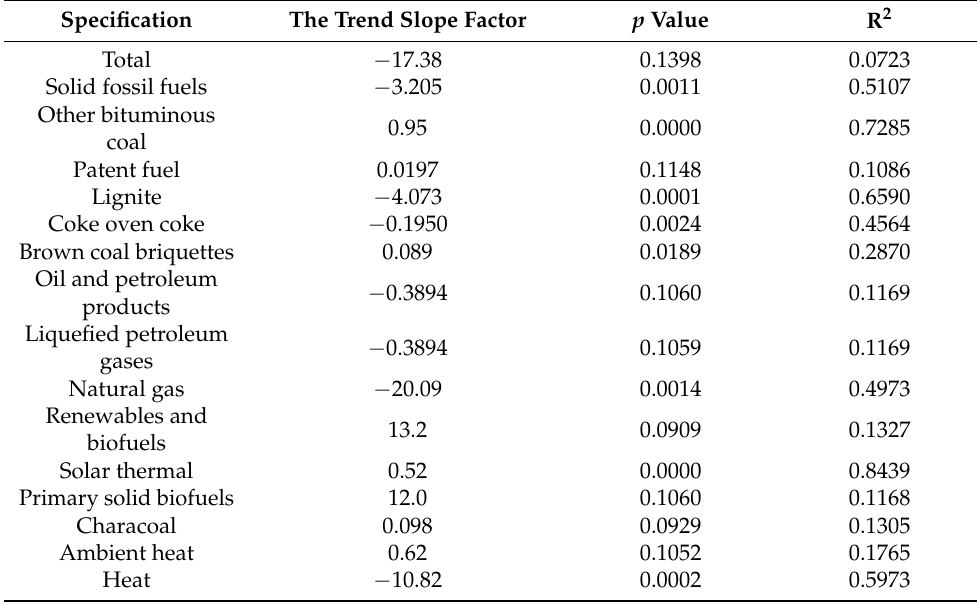
Table 5. Trends in the use of energy sources in Slovak households in